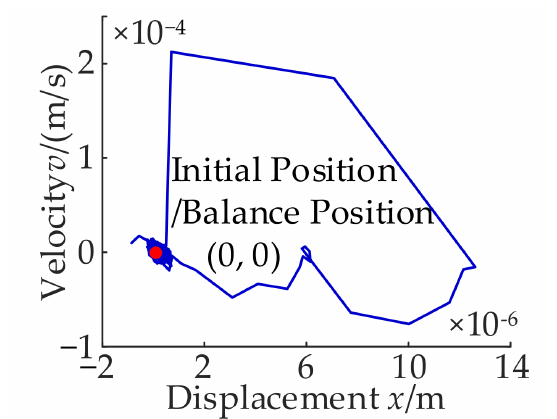
Figure 18. Phase trajectories of rotor by test when K p = − 70.